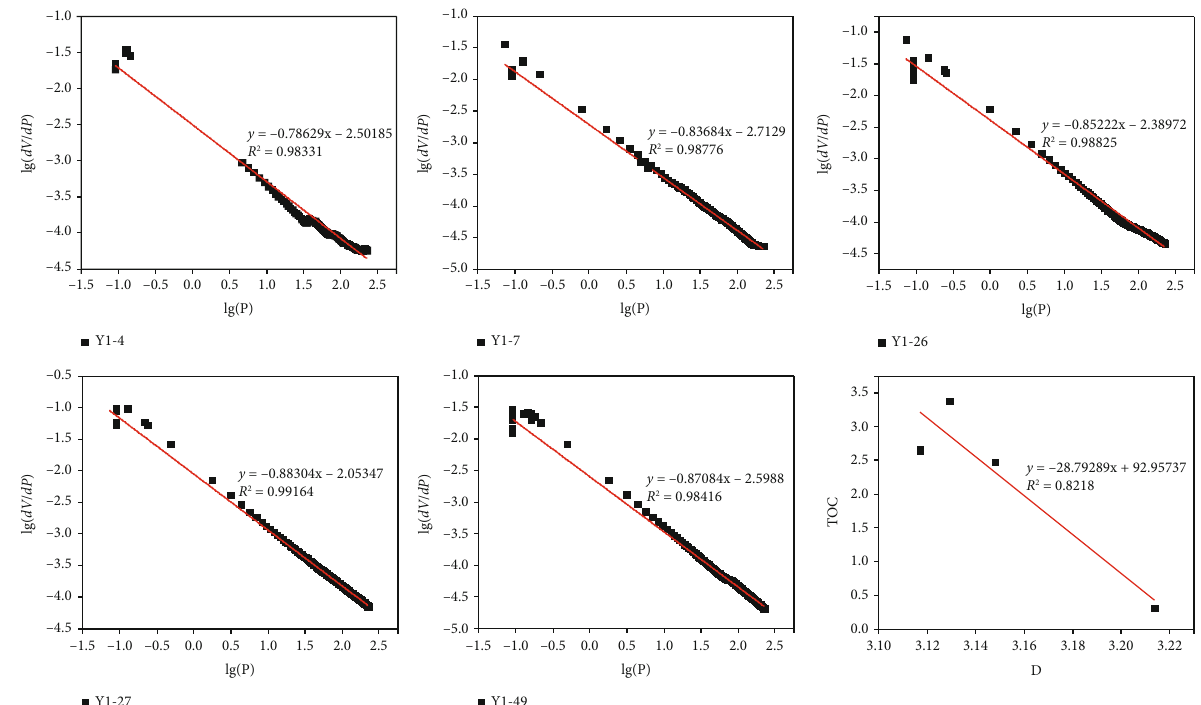
Figure 8: Fractal characteristics of pores in mercury injection experiments and the relationship between TOC and fractal